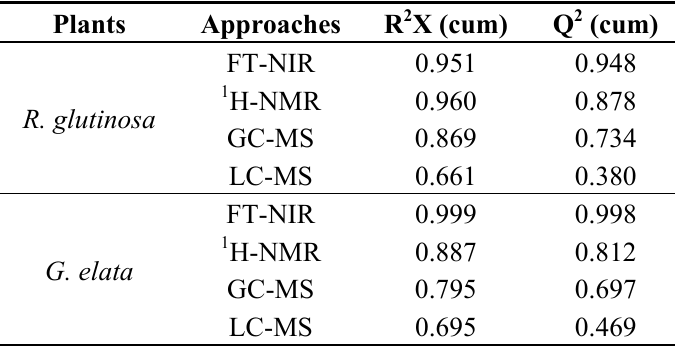
Table 4. Validation of the PCA